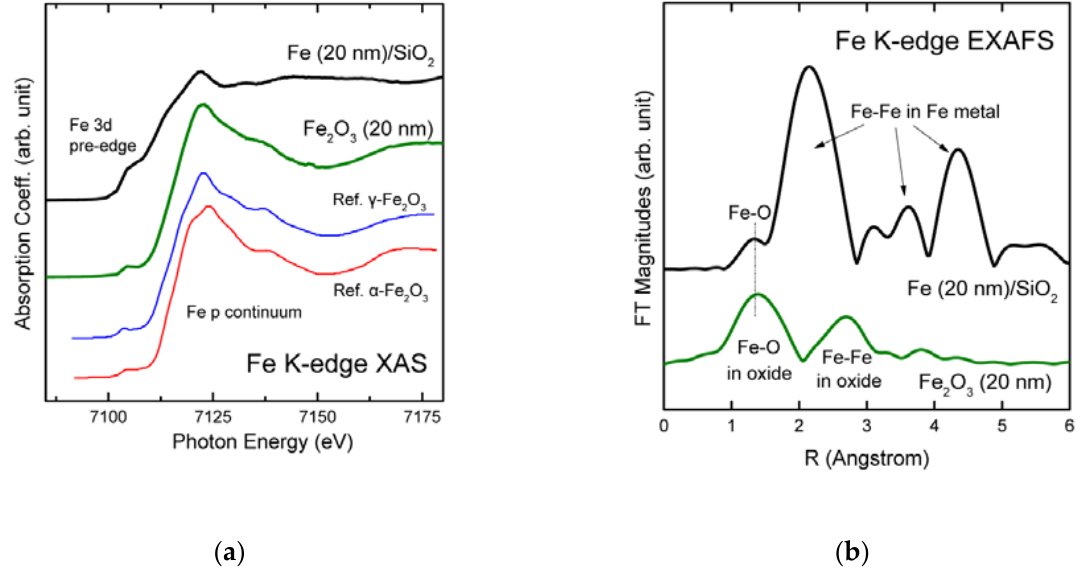
Figure 4. ( a ) Fe K-edge near-edge XAS spectra and ( b ) the Fourier-transformed extended X-ray absorption fine structures (FT EXAFS) magnitudes of the thick Fe and Fe 2 O 3 films. The results show the films are indeed in their respective intended compositions, implying that the spontaneous Fe oxidations observed in the soft XAS data cannot be attributed to possible oxidation during the growth process.